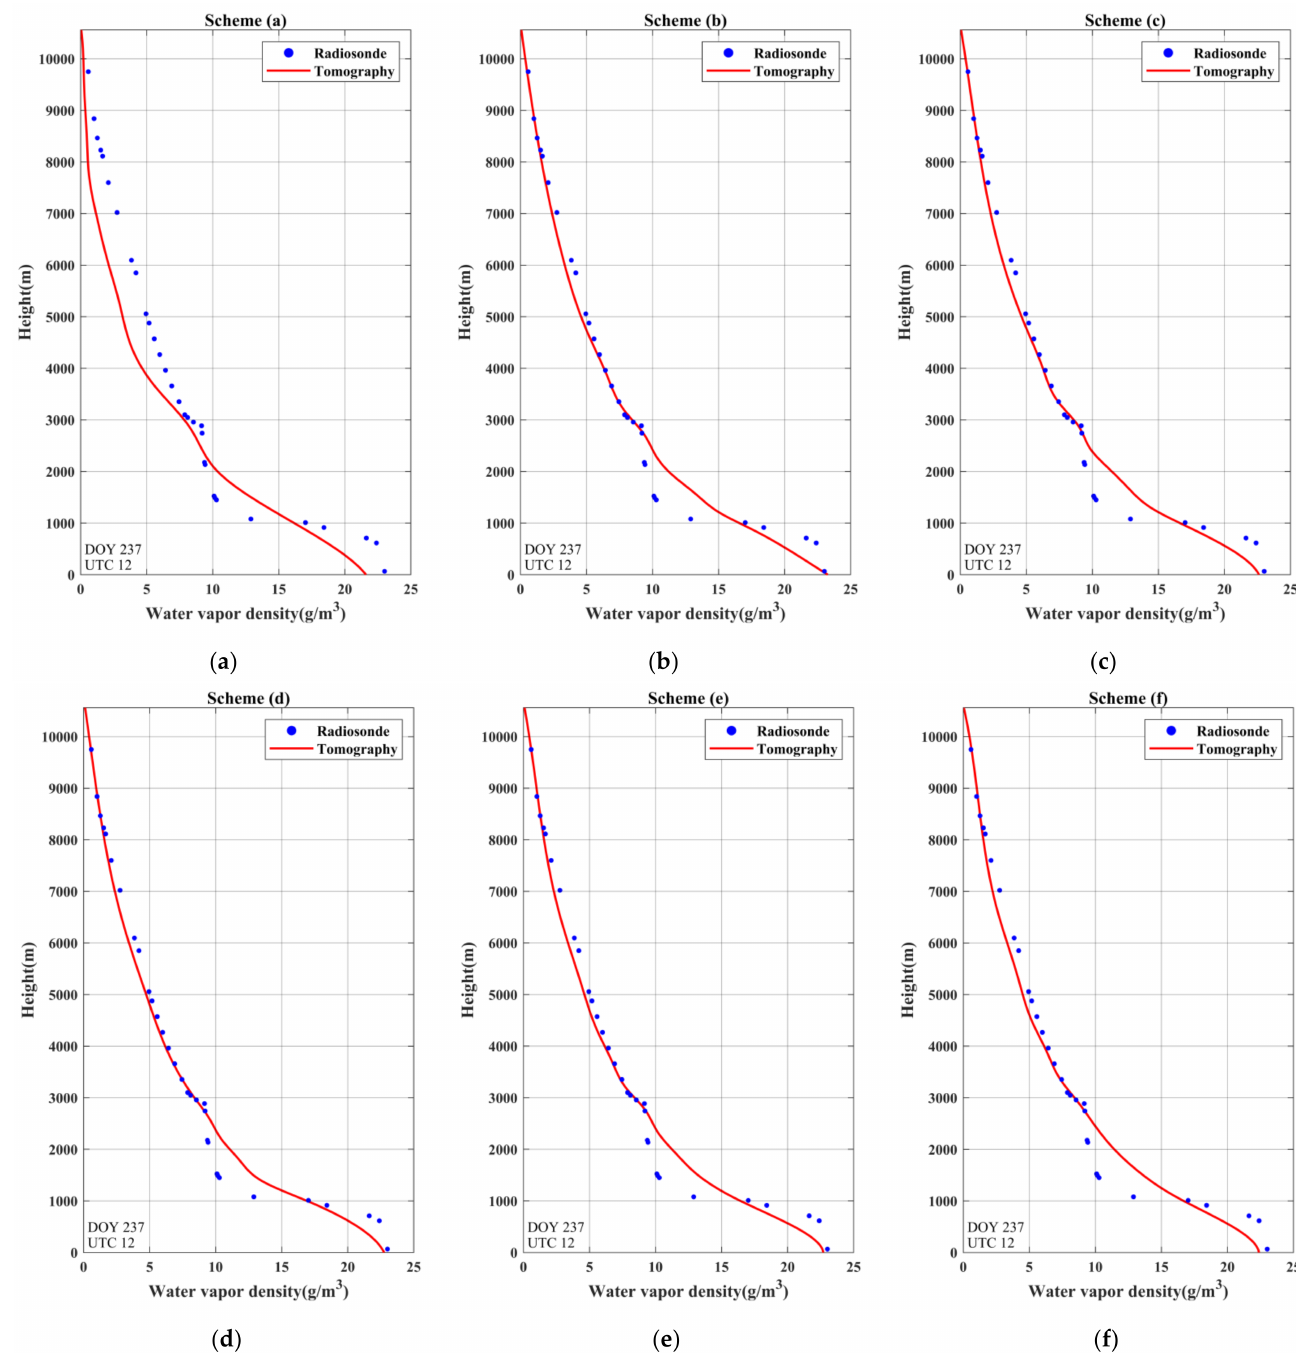
Figure 10. Comparison of water vapor density profiles derived from six schemes on DOY 237 at UTC 12:00. ( a ) Derived from uniform stratification; ( b – f ) derived from ANES with minimum height intervals of 350, 375, 400, 425 and 450 m,